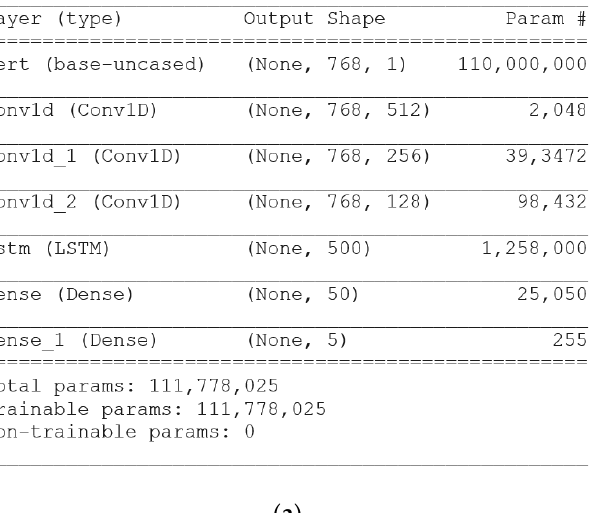
Figure 2. Architecture of recommender systems for streaming services based on hybrid deep learn- ing models of sentiment analysis and item genres.